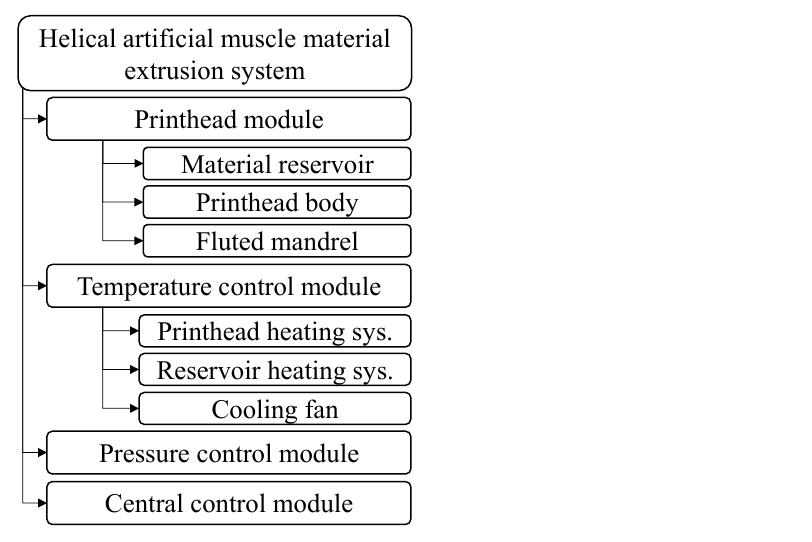
Figure 5. Framework of the helical artificial muscle material extrusion system.